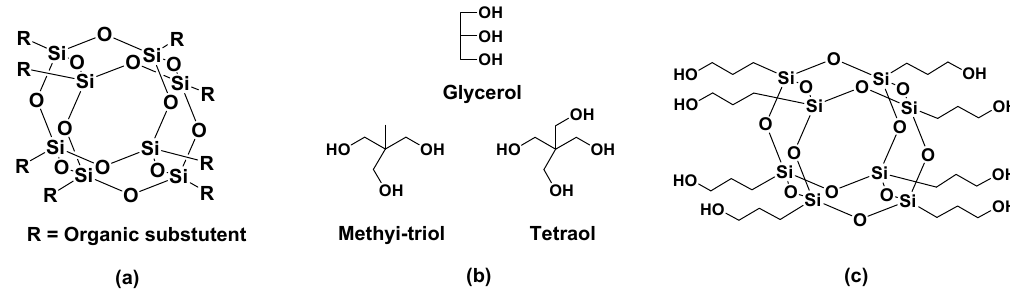
Figure 1. Structures of ( a ) POSS, ( b ) vegetable ester compound, and ( c ) octa-POSS-OH.